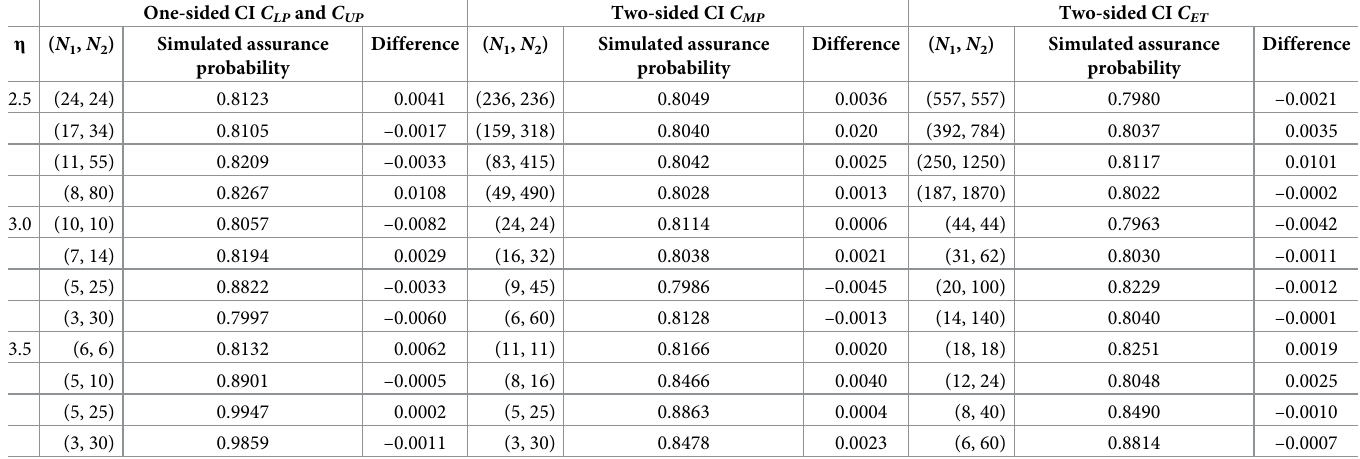
Table 4. The computed sample size, simulated assurance probability and errors for the 90% reference intervals of the distribution proportion 0.90 with assurance probability 0.80. One-sided CI C LP and C UP